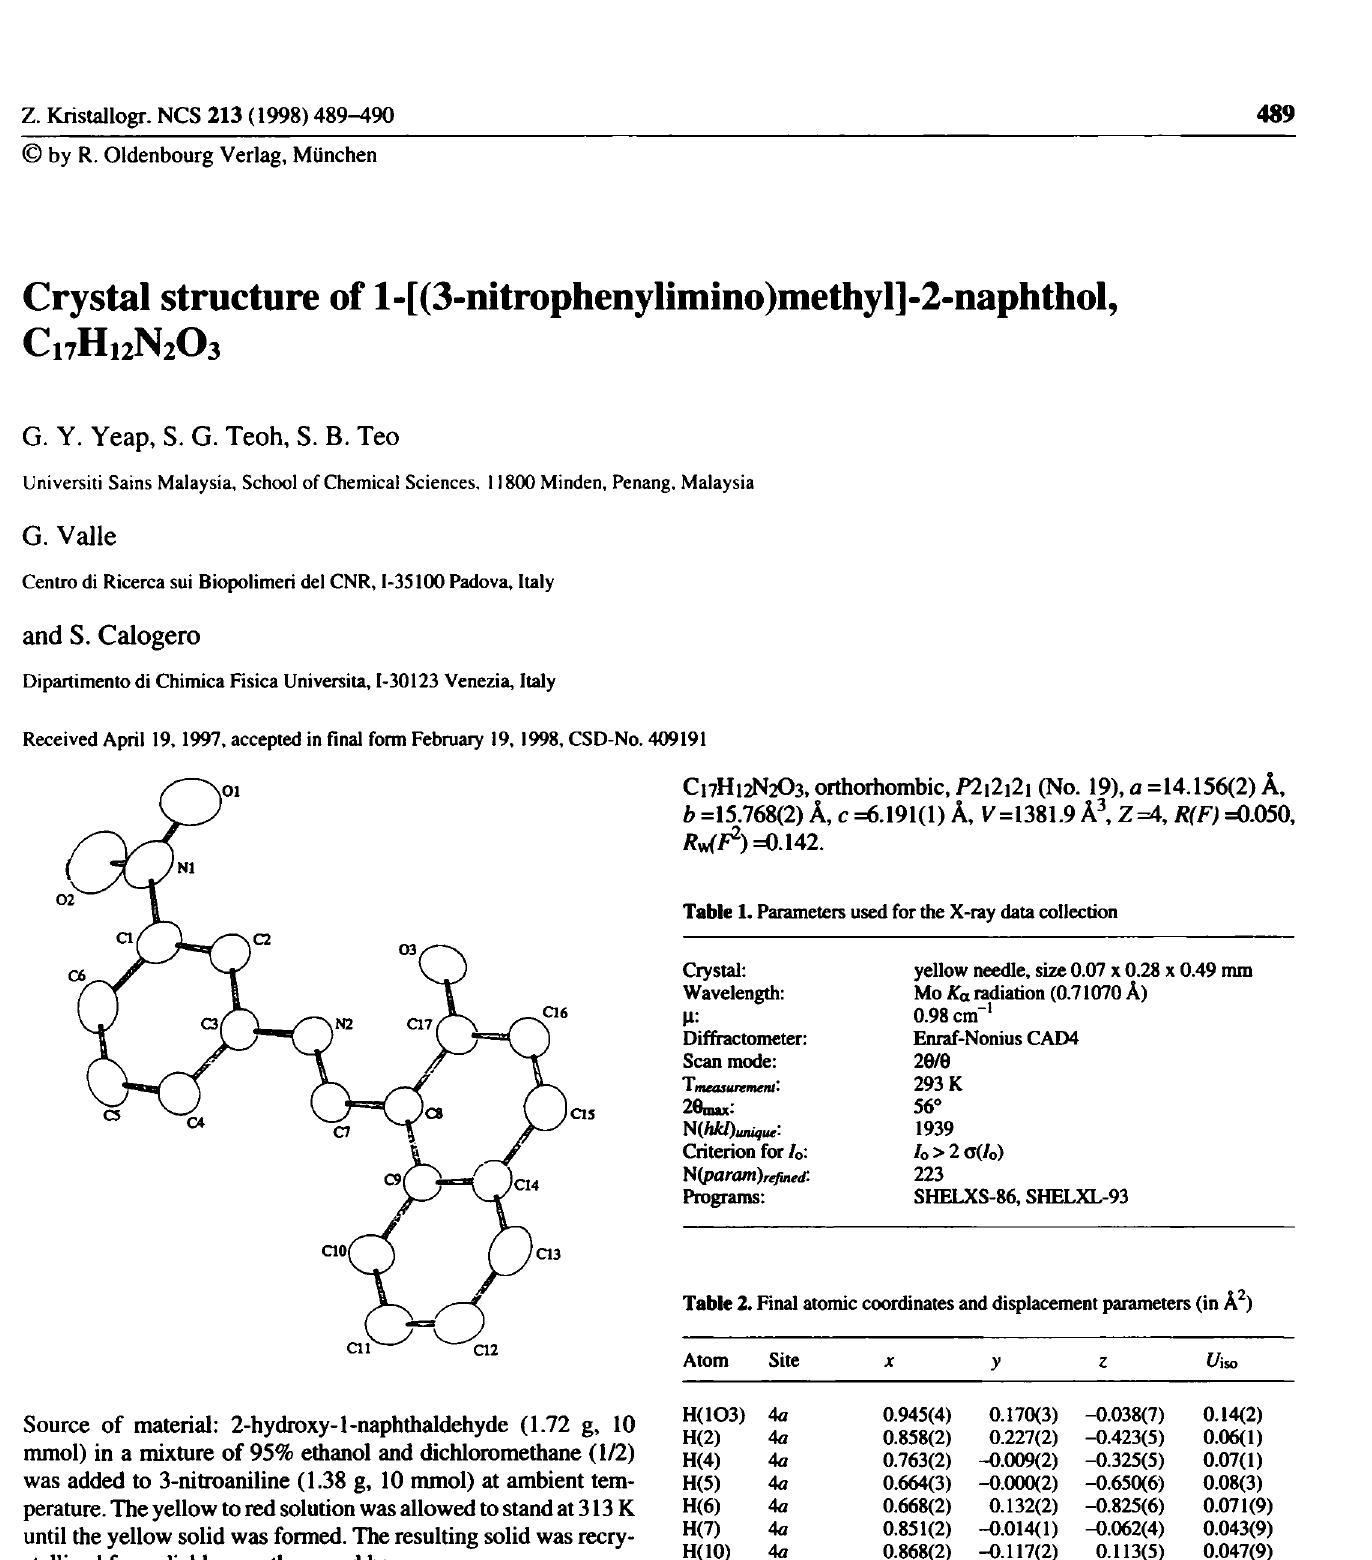
Table 2. Final atomic coordinates and displacement parameters (in